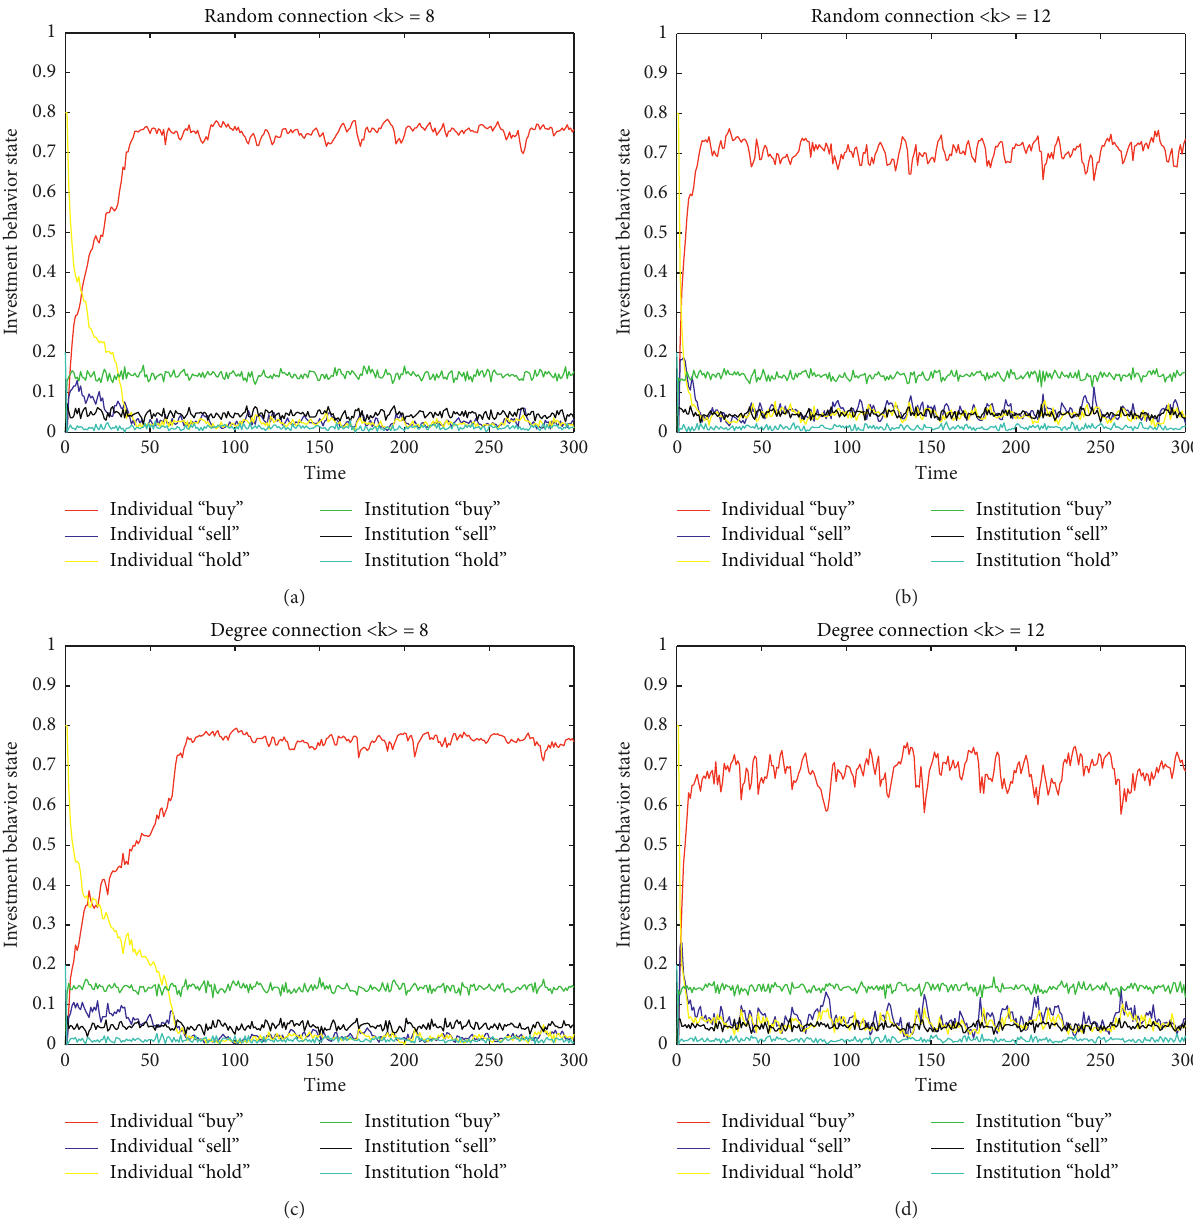
Figure 2: The impact of network structure on the evolution of investor